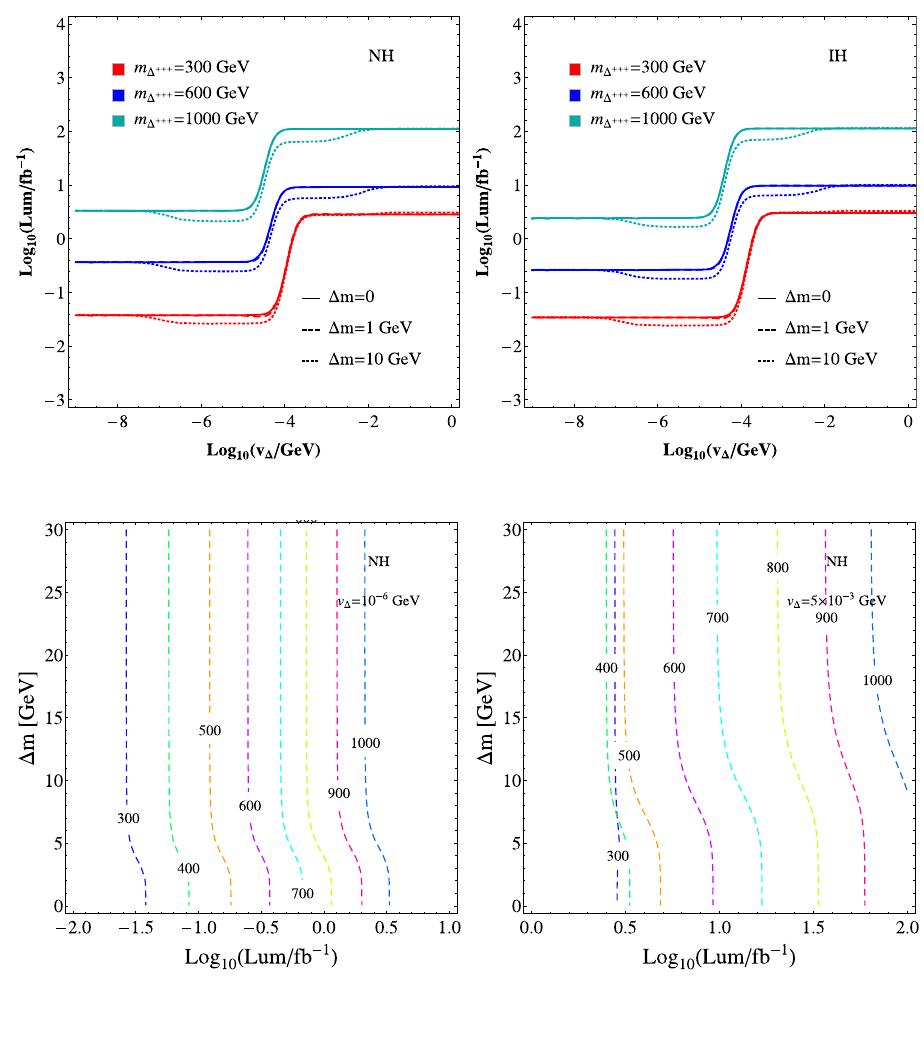
and m (cid:2) ±±± = 300 , 600 , 1000 GeV for the NH are depicted in the plane of log 10 (v (cid:2) / GeV ) and log 10 ( L / fb − 1 )